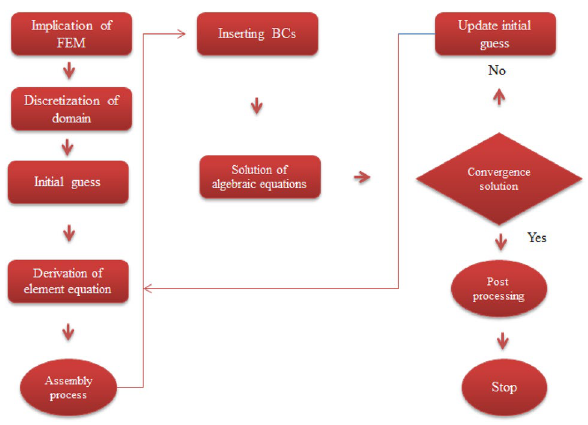
Figure 3. Flow chart related to